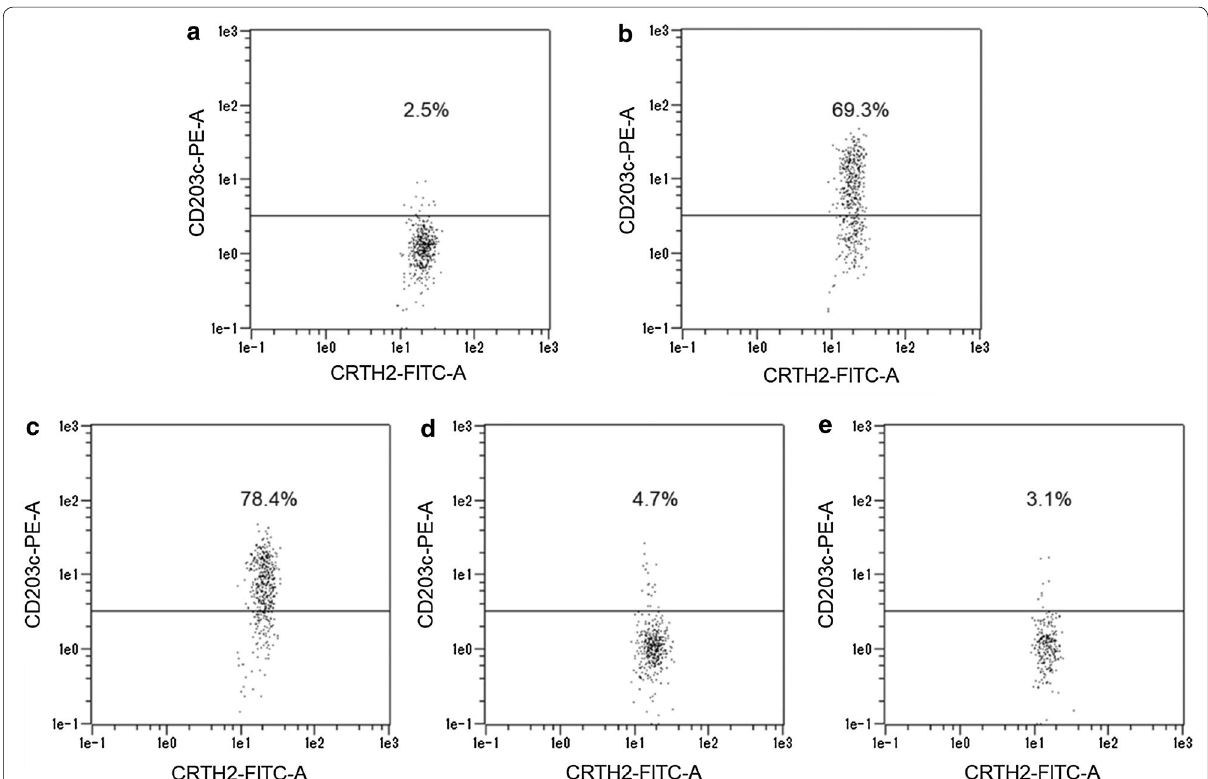
Fig. 3 Measurement of the percentage of CD203c-positive activated basophils. One example of the basophil activation test in this study. Allergens examined in the basophil activation test were a PBS (negative control), b anti-IgE antibody (positive control), c Cry j 1 and Cry j 2 (allergen components of the conventional immunotherapy), d WT-rice seed extract, and e Tg-rice seed extract. The threshold for CD203c-positivity was set at less than 5% of activated cells in the negative control. The upper region of the threshold defines CD203c-positive activated basophils and the percentage of those cells was measured by the flow cytometer